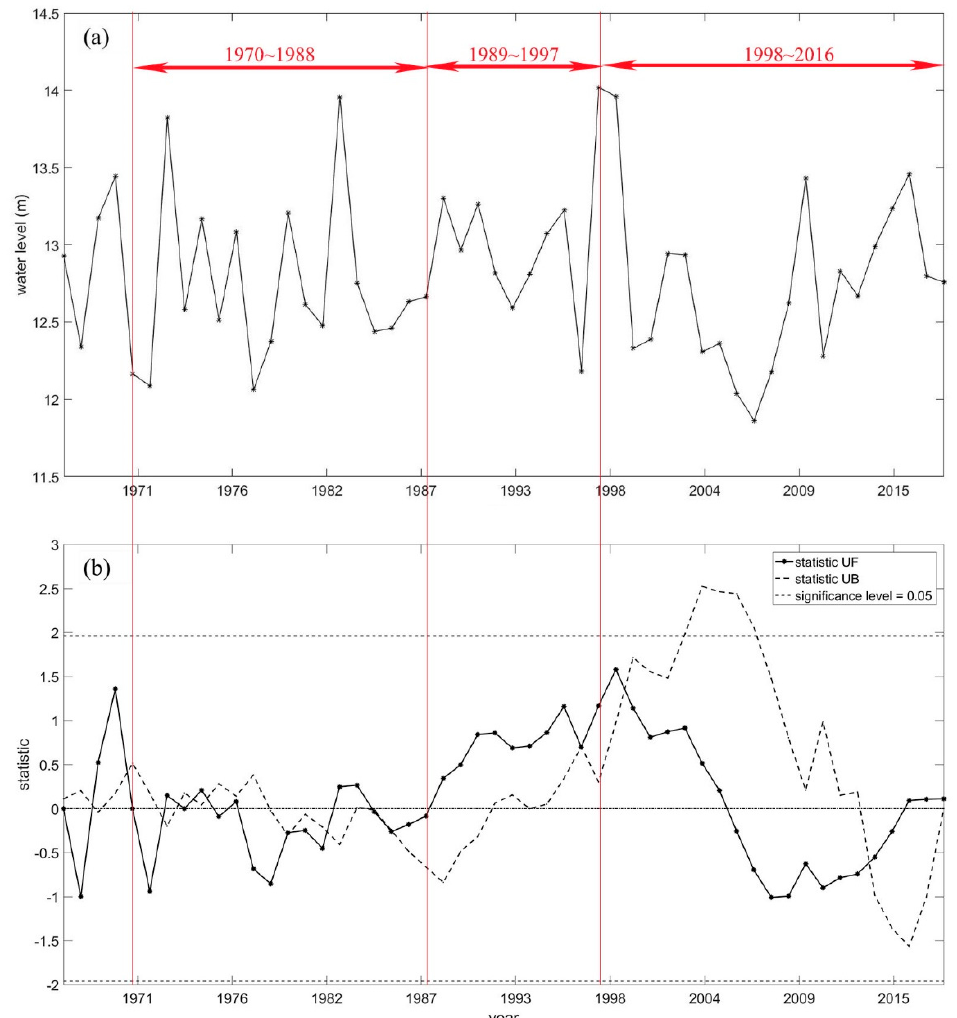
Figure 2. ( a ) Variation of annual water level series. The values are calculated using daily water level from 1967 to 2018; and ( b ) Mann–Kendall Trend Test (MK) of annual water level in Huayang Lakes.